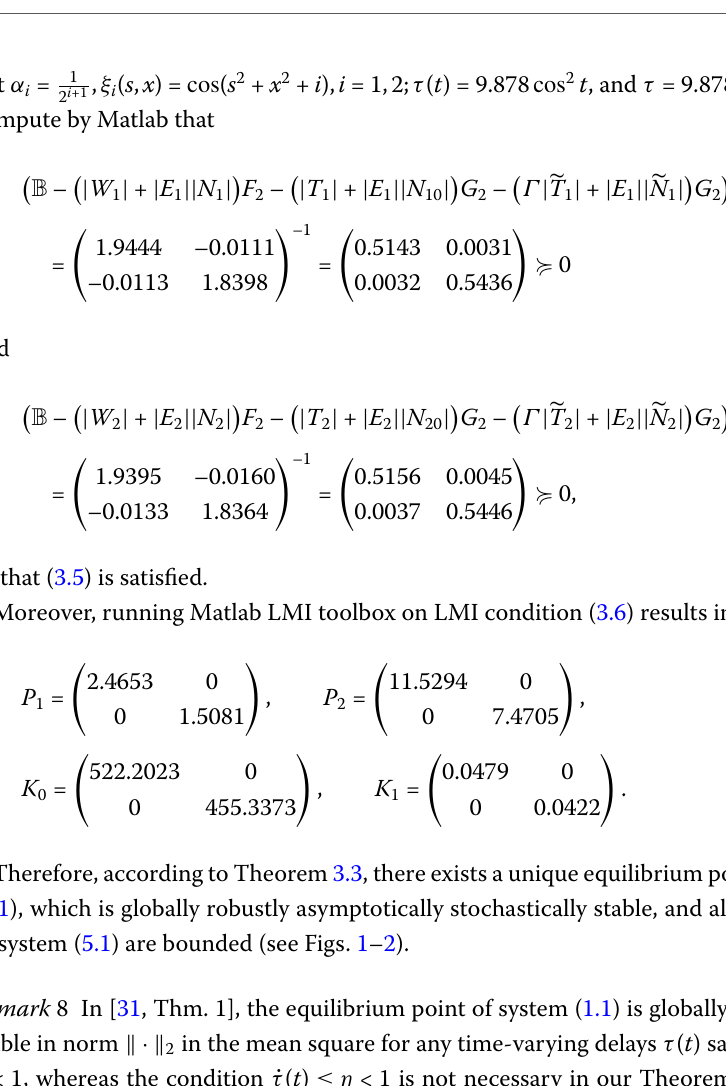
Figure 1 Computer simulations of the state u 1 ( t , x